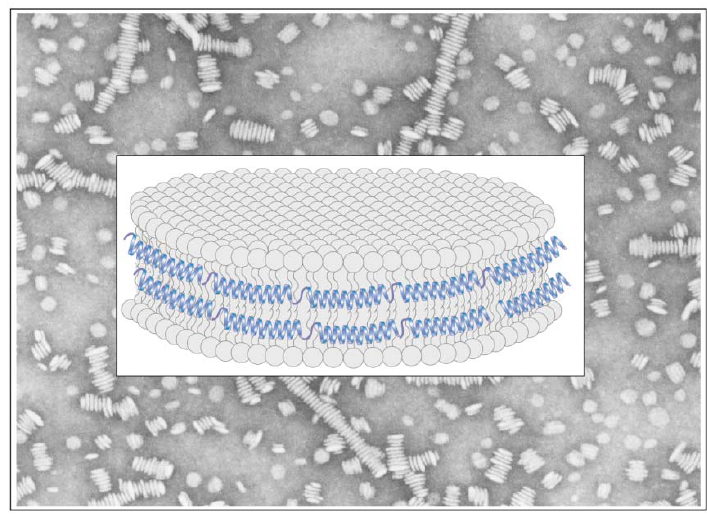
Figure 7. Lipid-associated conformation of M. sexta apoLp-III. Lipid-associated